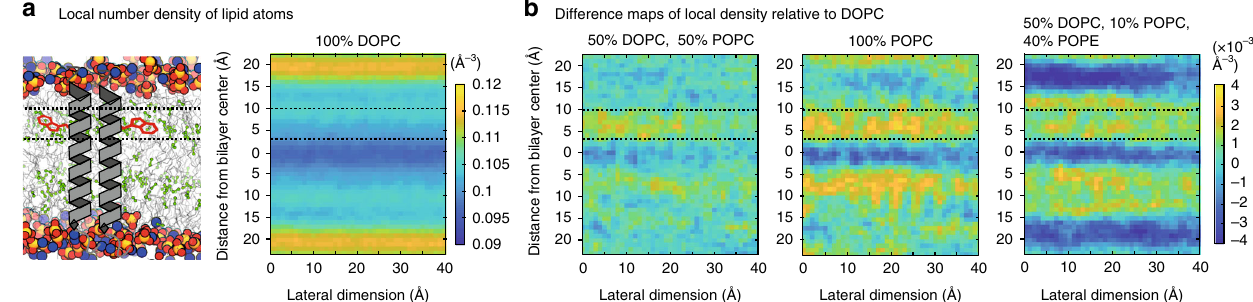
Fig. 7 The local number density of lipid atoms in a speci fi c region of the membrane correlates with Mga2 activation. a Snapshot from an all-atom MD simulation of a protein-free DOPC bilayer (left) and the derived local number density of lipid atoms (right). A schematic representation of the dimeric TMH of Mga2 in the left panel is provided to indicate the relative position of the sensory tryptophan W1042 (red sticks and dashed line). The position of double bonds in the lipid acyl chains is given by green spheres, whereas a schematic representation of the Mga2-TMH is given to guide the eye. The number density of lipid atoms in cubic boxes with a side of 1 Å was calculated and plotted (right panel) for different depths in the bilayer (distance for bilayer center) and different lateral positions (lateral dimension). Highest local number densities are indicated in yellow and are observed in the region of the lipid headgroups. Lowest densities are indicated in dark blue and observed in the center of the lipid bilayer. For details see the Supplementary Materials. b Difference maps of the local density were determined by subtracting the local number density of lipid atoms of DOPC from the one of the indicated bilayer systems. Increased packing densities relative to the DOPC bilayer are indicated in yellow, whereas decreased densities are indicated in blue. The region probed by the sensory tryptophan 25 is indicated by two dashed lines. Changes in lipid saturation and the lipid headgroup region have qualitatively distinct impact on the distribution of local packing densities. Source data are provided as a Source Data fi